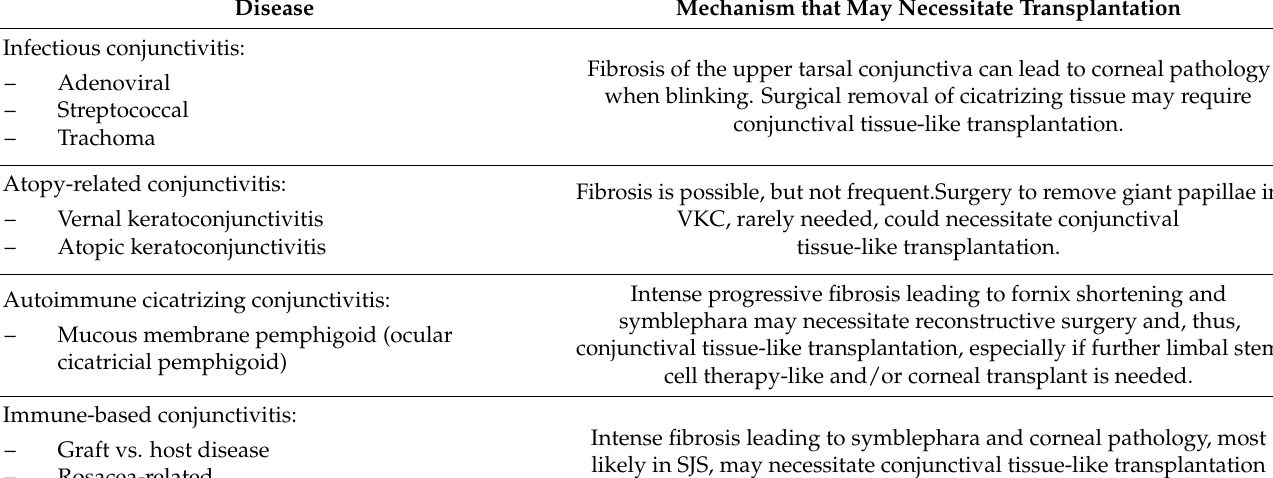
Table 1. Summary of the main conjunctival diseases that may require tissue transplantation.